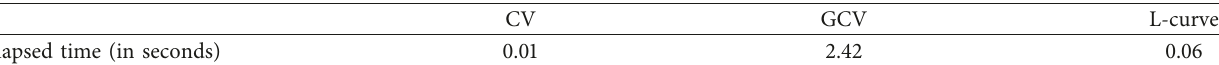
Table 3: The result of the comparison between cross validation (CV), generalized cross validation (GCV), and L-curve criterion in PLS regression in terms of speed of execution in the case of real